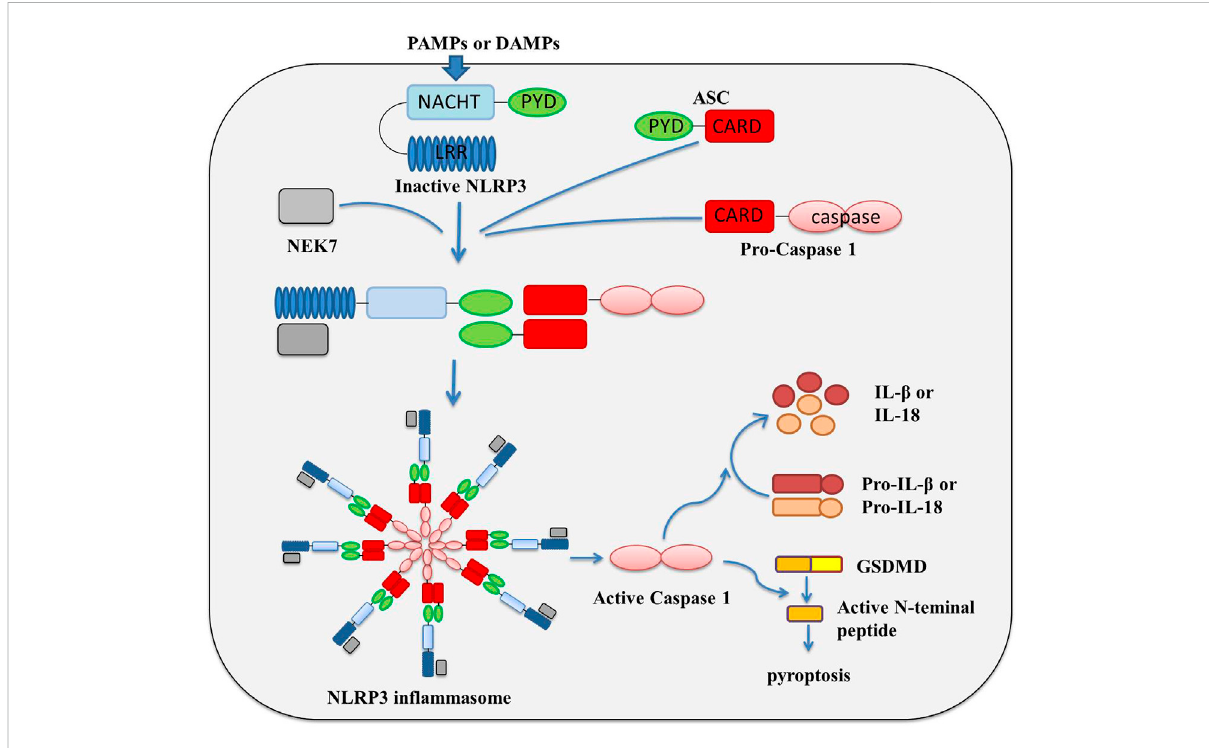
FIGURE 1 Activation and assembly Mechanism of NLRP3 in fl